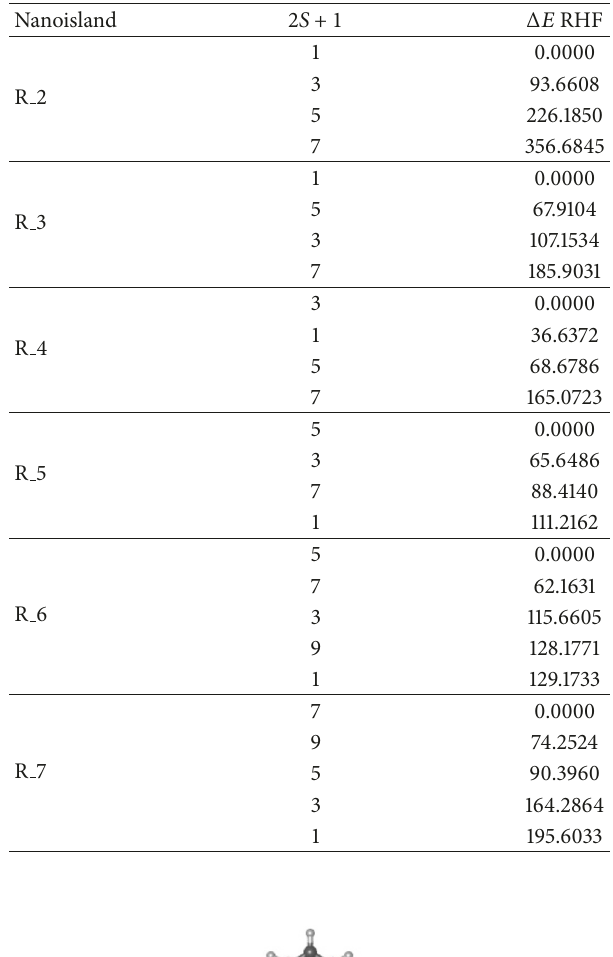
Table 6: Energy differences ( Δ𝐸 ) for the different rhombuses nanoislands in kcal/mol.